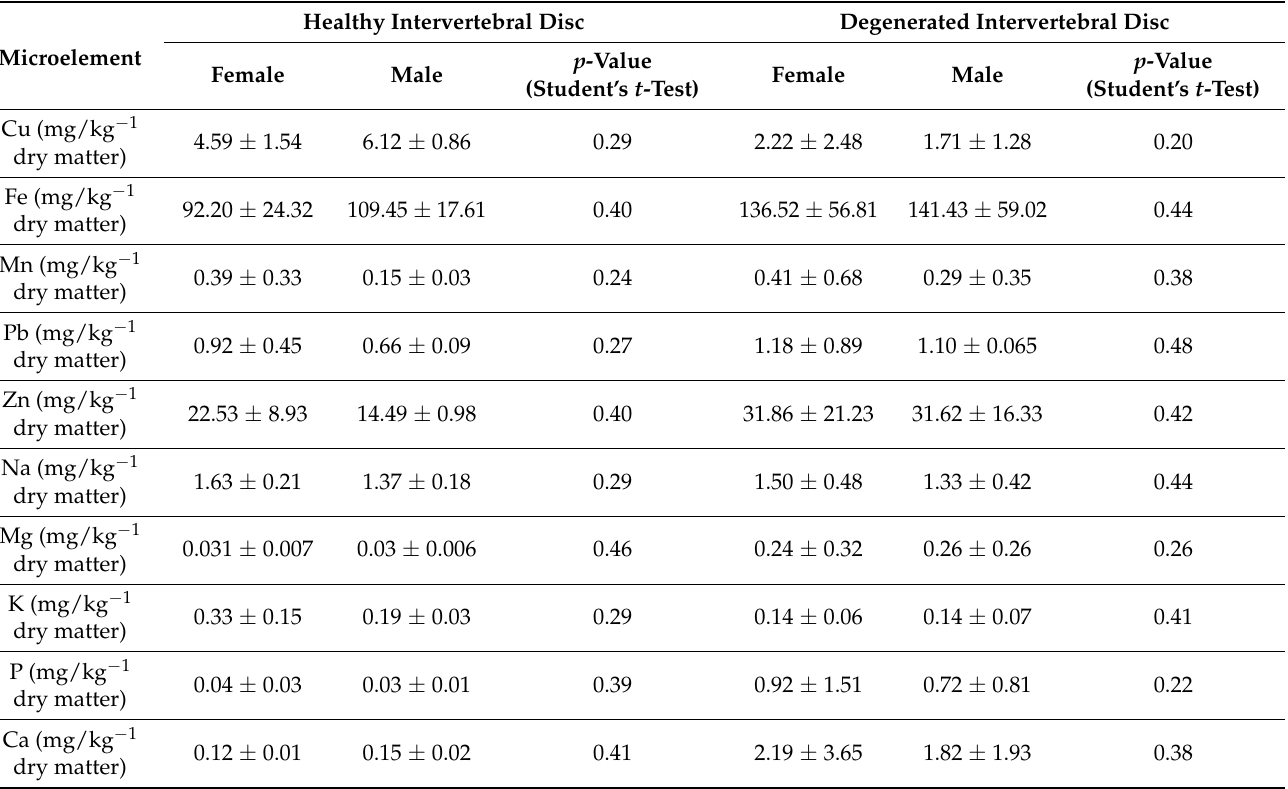
Table 4. Concentrations of selected elements in women and men in the study and control groups. Healthy Intervertebral Disc Degenerated Intervertebral